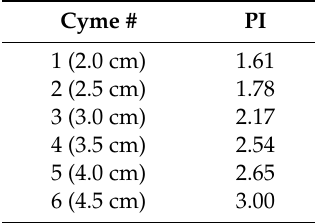
Table 2. Plastochron indices (PIs) of the six cymes in Group 2 plants. A corolla reference length of 1.5 cm was used to calculate these six plastochron indices. Values in parentheses are the corolla lengths of flowers at position 1 in each of these six